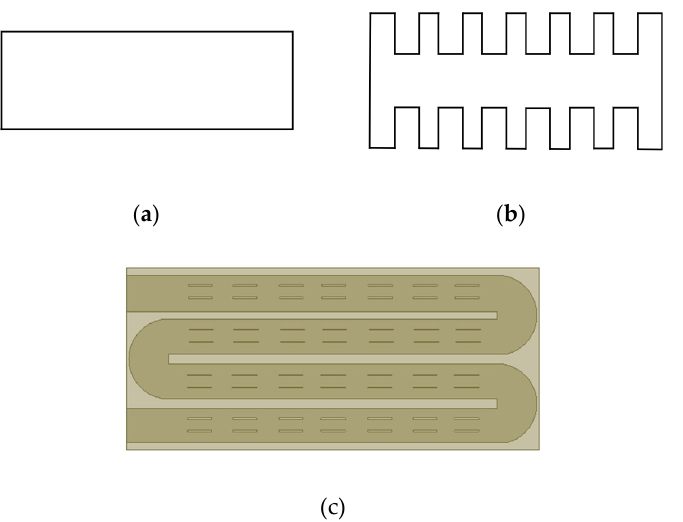
Figure 11. Three different flow channel structures of the heatsink: ( a ) Rectangular structure, ( b ) Concave–convex structure, ( c ) Fin structure.